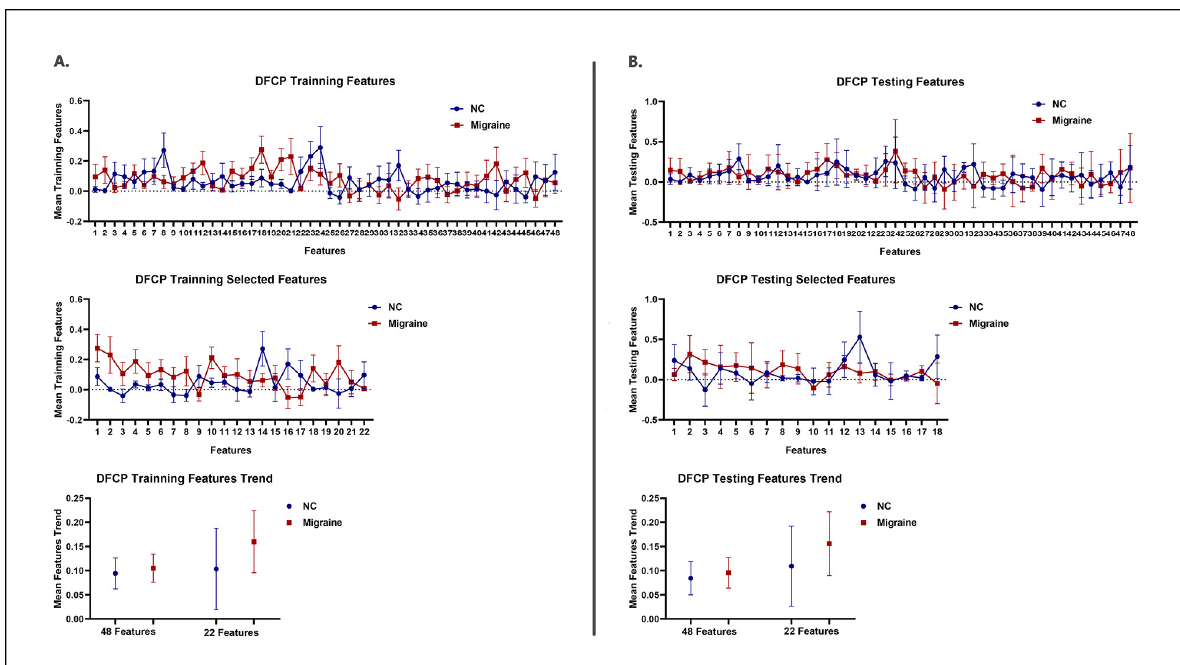
Figure 6. Features for DFCP classification approach. ( A ) The top picture shows mean training DFCP features with CI of 95% for two groups in all DFCP feature states. The middle picture displays mean training DFCP features with CI 95% for two groups in the selected DFCP feature states after SVM−RFE algorithm. The line presents the changing trend of features in two plots. The bottom picture shows the mean value with CI of 95% of the line in the top picture and the middle picture. ( B ) The top picture shows mean testing DFCP features with CI 95% for two groups in all DFCP feature states. The middle picture displays mean testing DFCP features with CI 95% for two groups in the selected DFCP feature states after SVM−RFE algorithm. The line presents the changing trend of features in two plots. The bottom picture shows the mean value with CI of 95% of the line in the top picture and the middle picture.